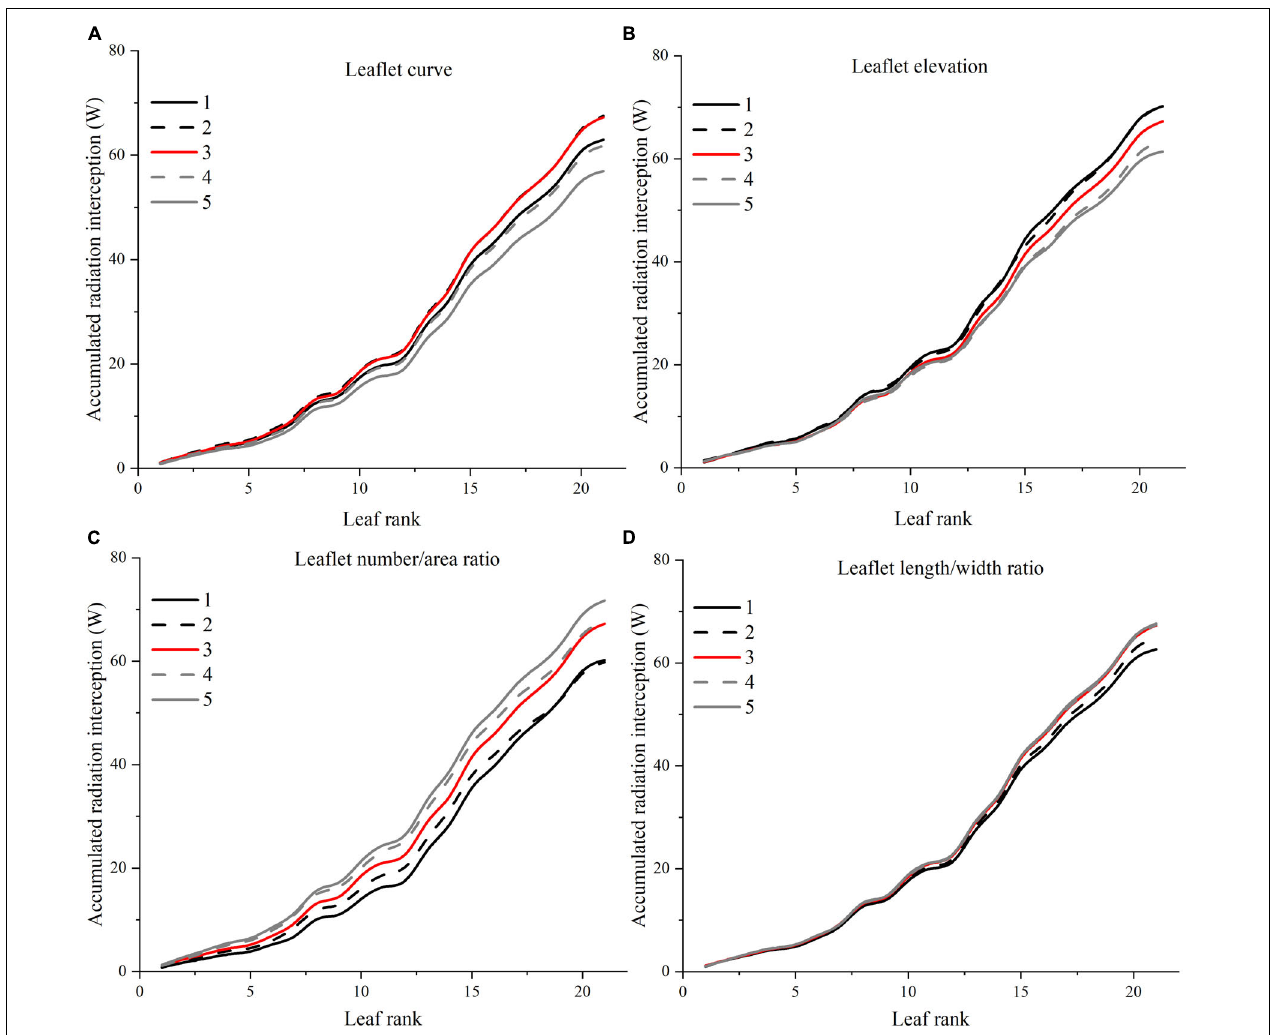
FIGURE 11 | Effects of different leaflet architectural shapes on accumulated radiation interception as leaf rank increases. Simulated for the canopy located at the middle of the greenhouse to avoid any border effects. E.g., leaflet curve (A) , leaflet elevation (B) , leaflet number/area ratio (C) , and leaflet length/width ratio (D)